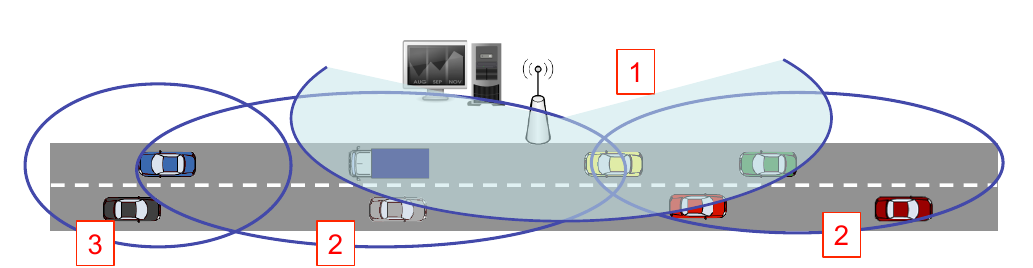
Figure 3. Example of an RoI.